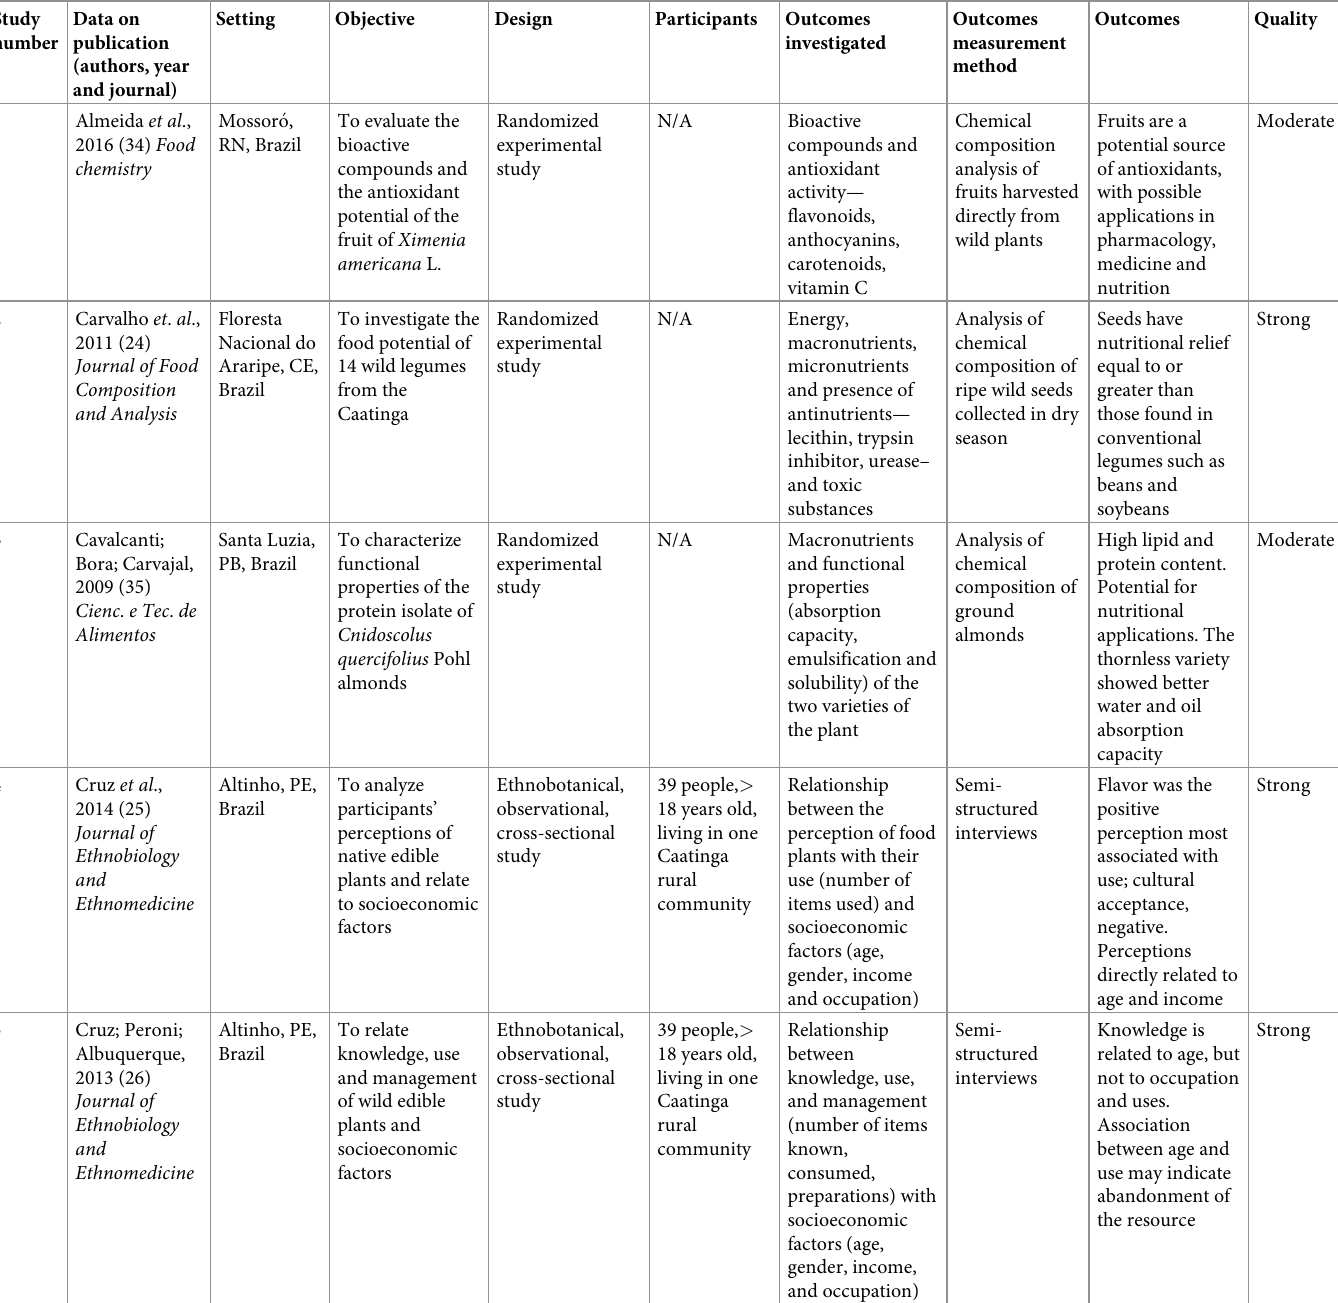
Table 1. Characterization of studies regarding biodiverse food plants in Caatinga